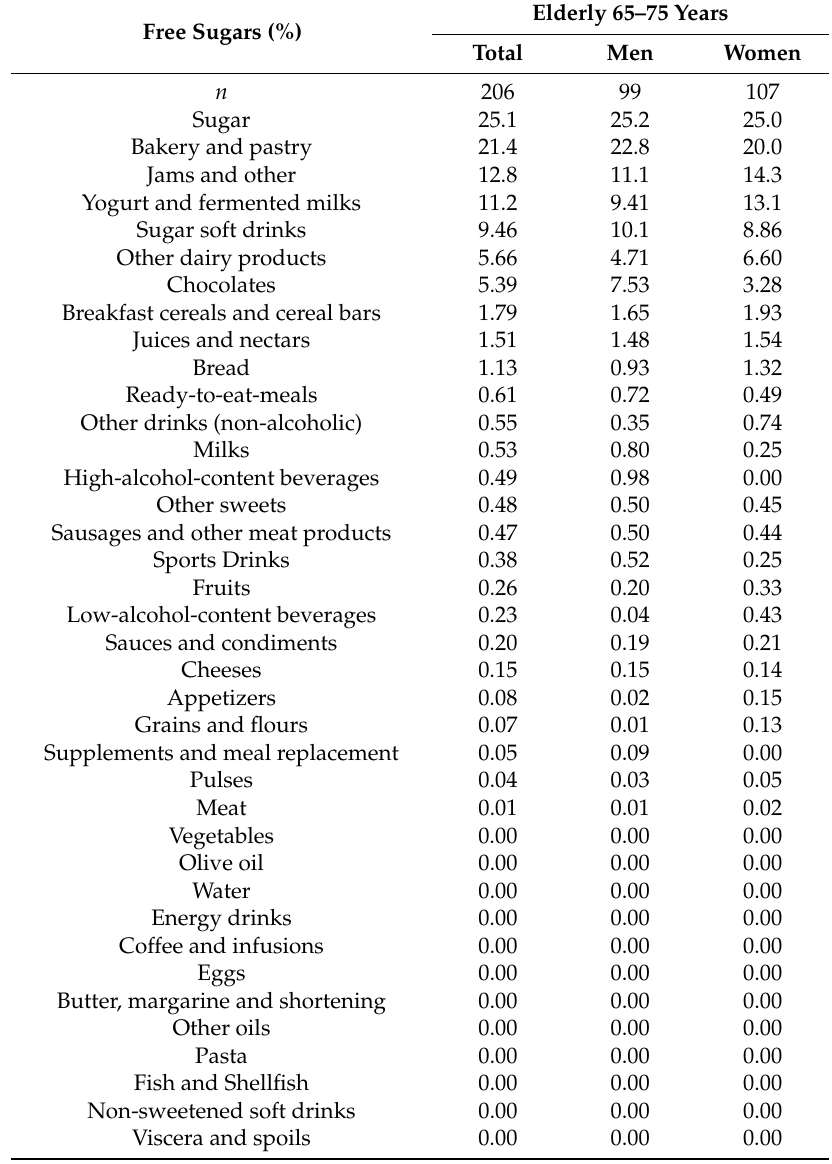
Table 14. Dietary sources of free sugars (%) from food and beverage subgroups in the ANIBES Study Spanish population aged 65–75 years: